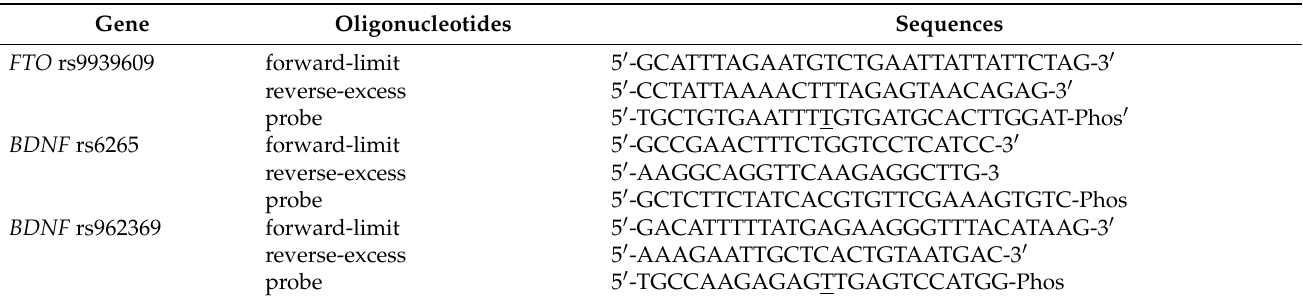
Table 1. Sequences of